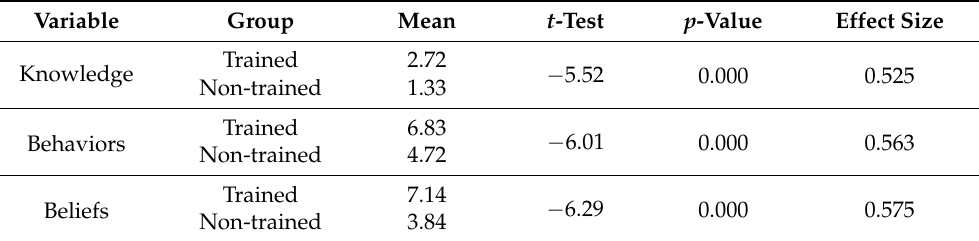
Table 5. Overall scores for farmers’ knowledge, behaviors, and